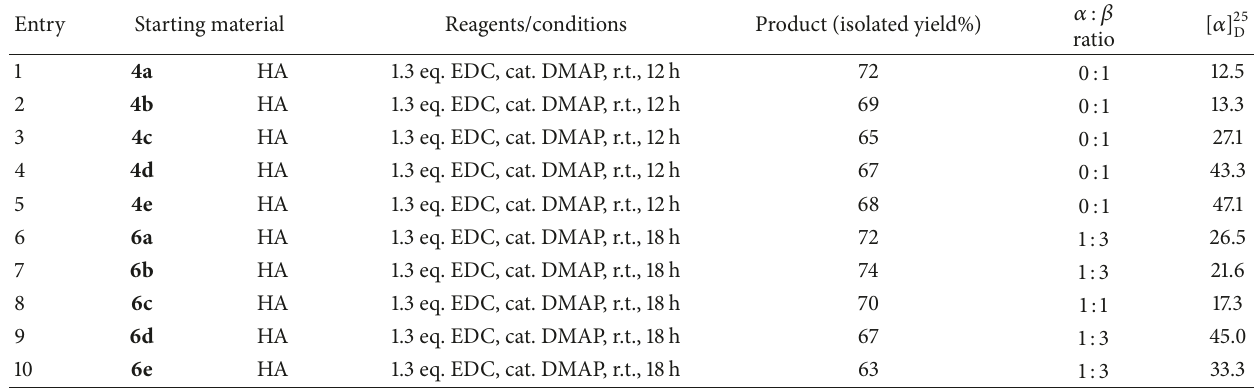
Table 2: Coupling conditions and isolated yield for 5a – e and 7a – e .